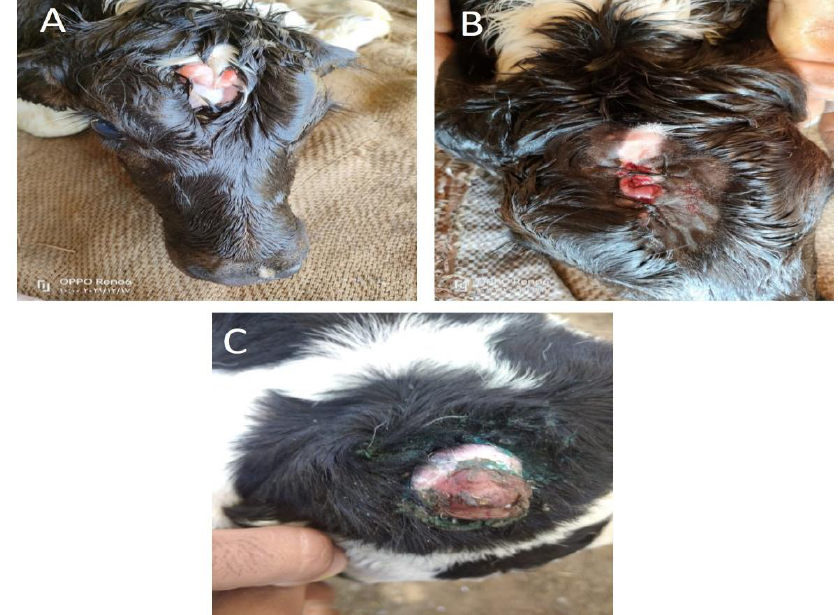
Fig. 5: Gross pictures showing a case of cranioschisis in mixed breed calves before (A) and after surgical intervention (B) and another case of cranioschisis 45 days following wound dehiscence